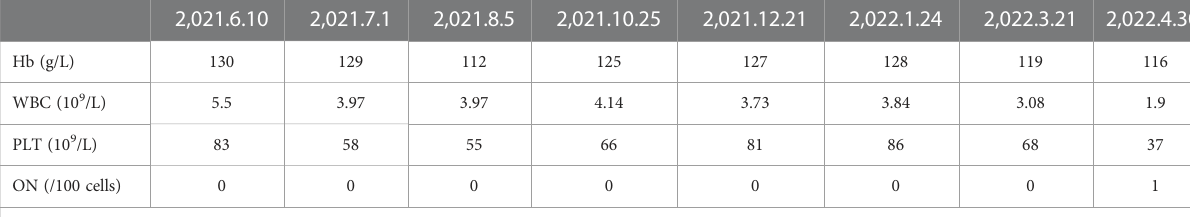
TABLE 1 Peripheral blood tests during osimertinib and adjuvant